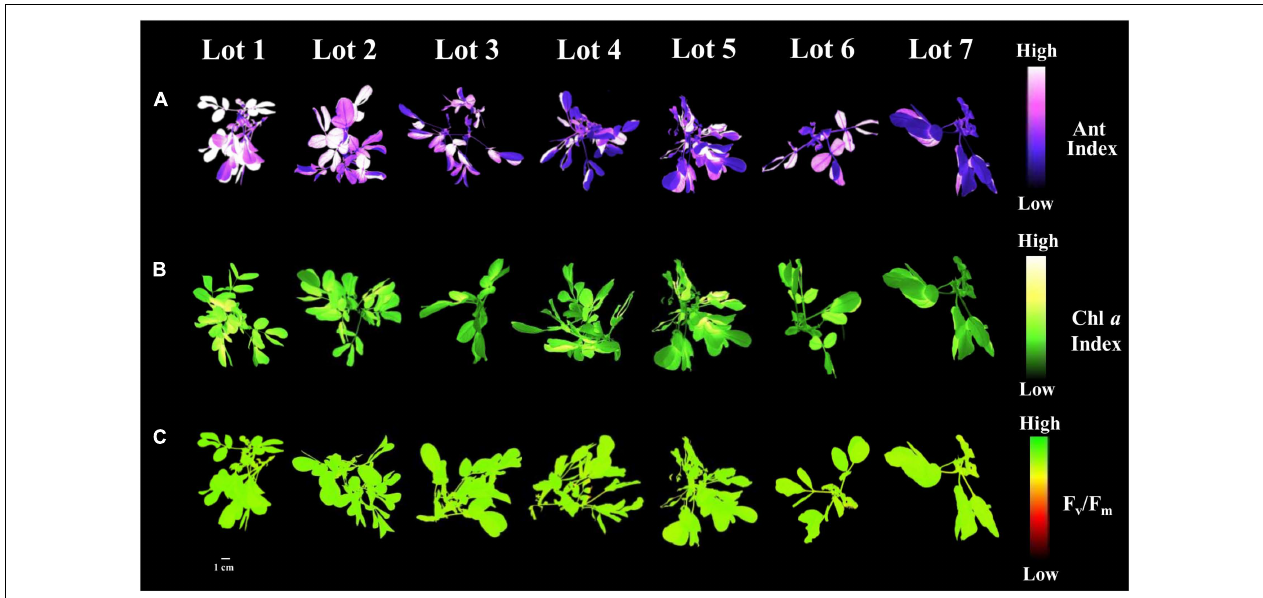
FIGURE 11 | Anthocyanin index (A) , chlorophyll a index (B) , and maximum quantum efficiency of photosystem II based on F v /F m (C) in peanut seedlings ( Arachis hypogaea L.; cv. IAC OL3) from seedlot 7. The pigments and photosynthetic efficiency of peanut seedlings were evaluated at 14 days after sowing of the seeds from the seven lots studied. Each pixel in the image is represented by a unique value that corresponds to fluorescence intensity; higher pixel values indicate higher anthocyanin, fluorescence and F v /F m